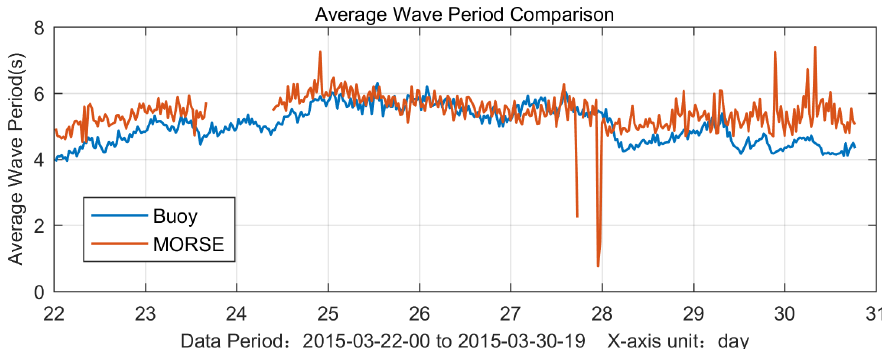
Figure 14. Average wave period measured by MORSE and the